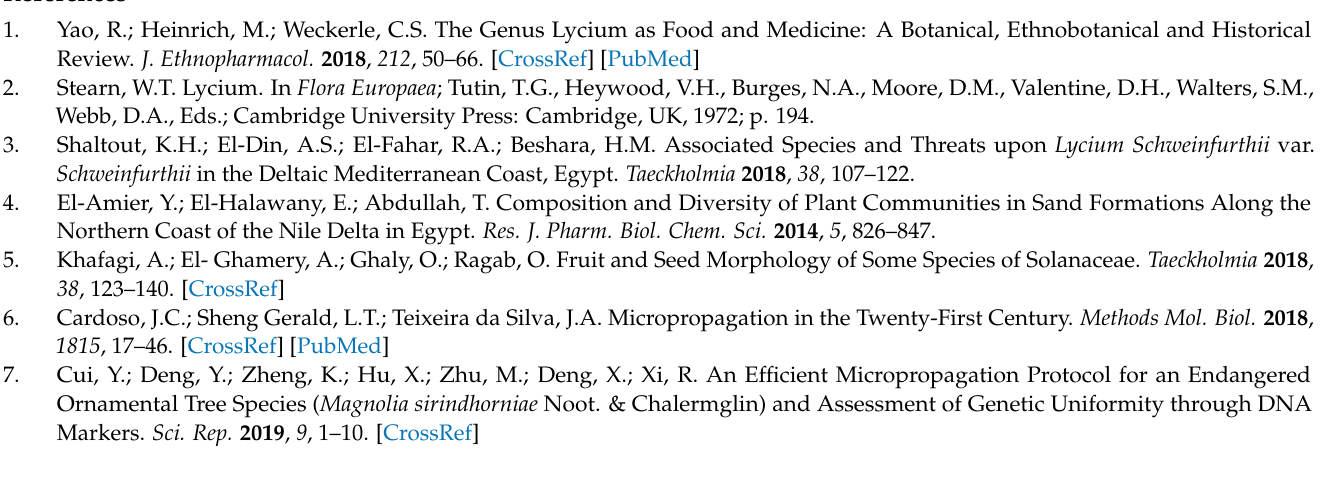
Figure S2: The blooming of L. schweinfurthii during the spring season. Figure S3: L.schweinfurthii branch showing leaves and immature fruits. Figure S4: Ripe fruits of L. schweinfurthii . Figure S5: Calibration range of the HPTLC analysis of micropropagated dry leaves’ extract samples against a reference of ferulic acid 400 µ g ml − 1